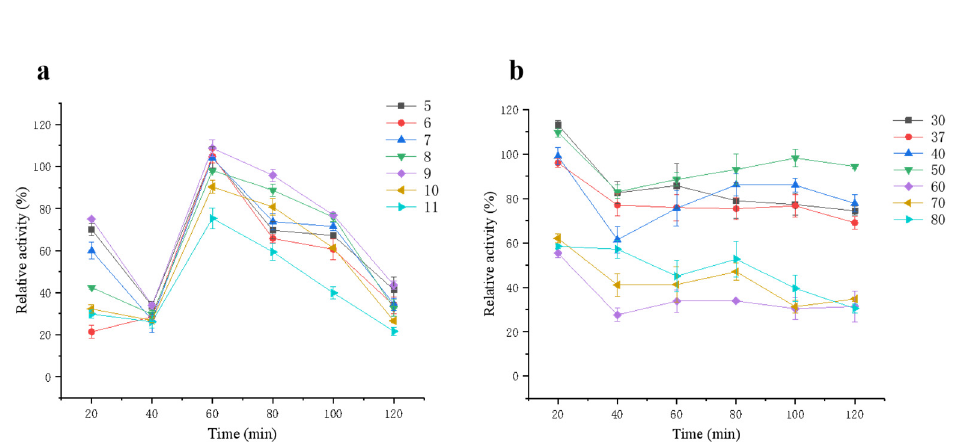
Figure 5. ( a ) Effect of pH on the stability of recombinant collagenase. ( b ) Effect of temperature on the stability of recombinant